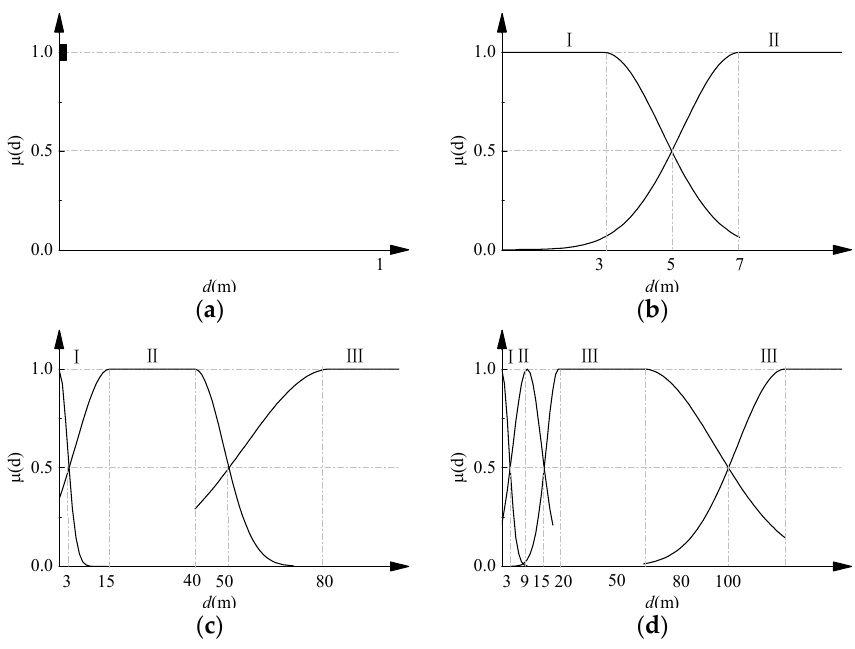
Figure 3. Membership function of thickness of covering layer. ( a ) 800 ≥ v s > 500; ( b ) 500 ≥ v s >